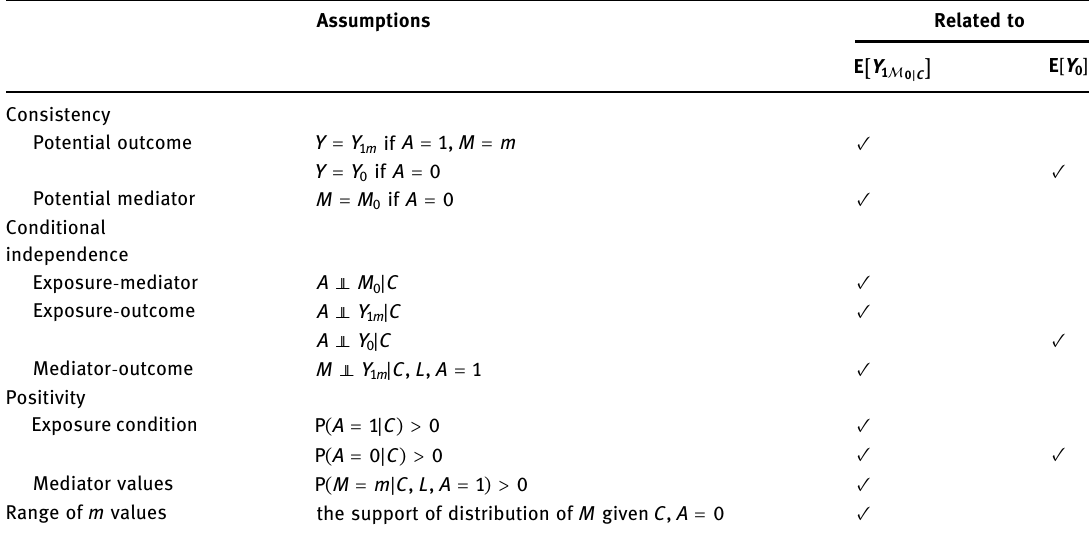
Table 7: Identifying assumptions for